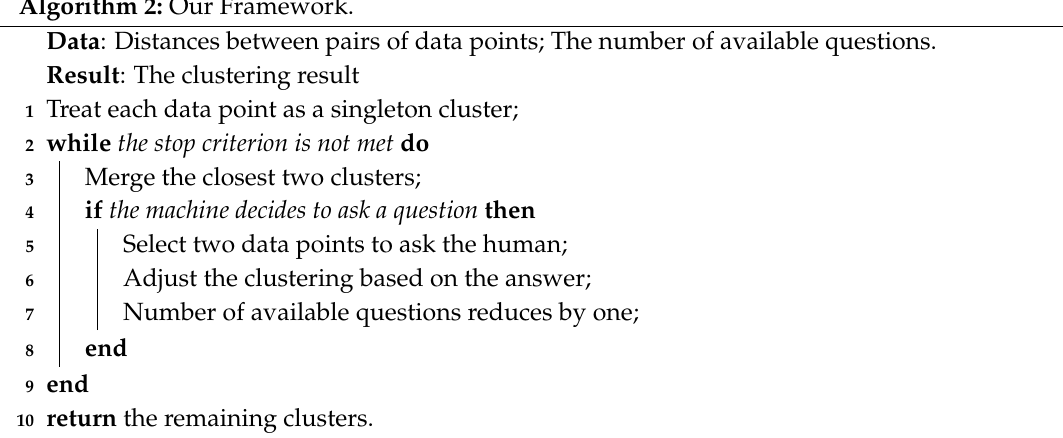
Algorithm 2: Our